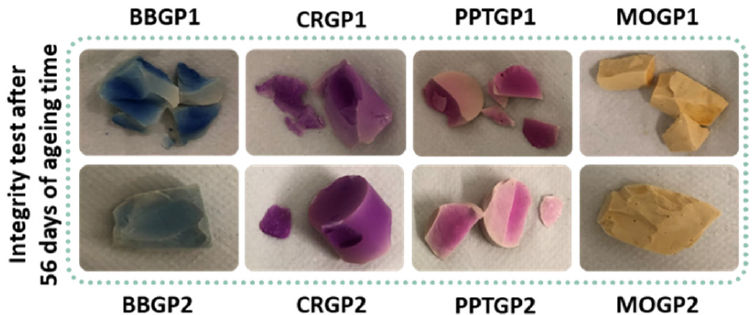
Figure 9. Images of the coloured geopolymers after integrity tests at 56 days of ageing.